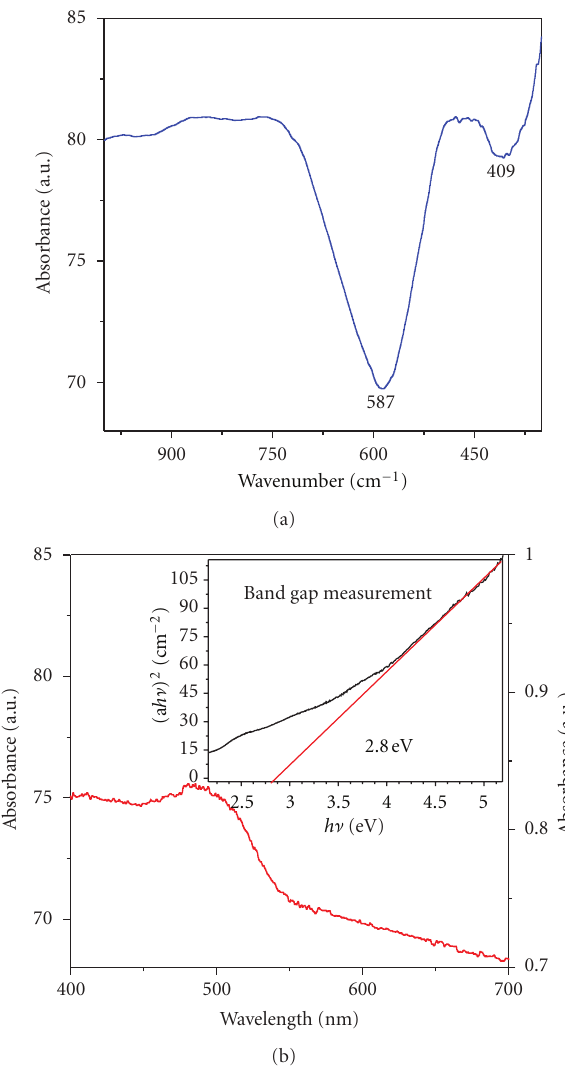
Figure 2: (a) IR and (b) UV-vis spectra of as-prepared CoFe 2 O 4 – Fe 3 O 4 magnetic nanocomposites. Inset: Plot of ( αhυ ) 2 versus hυ to determine the band gap energy using Tauc relation [18].